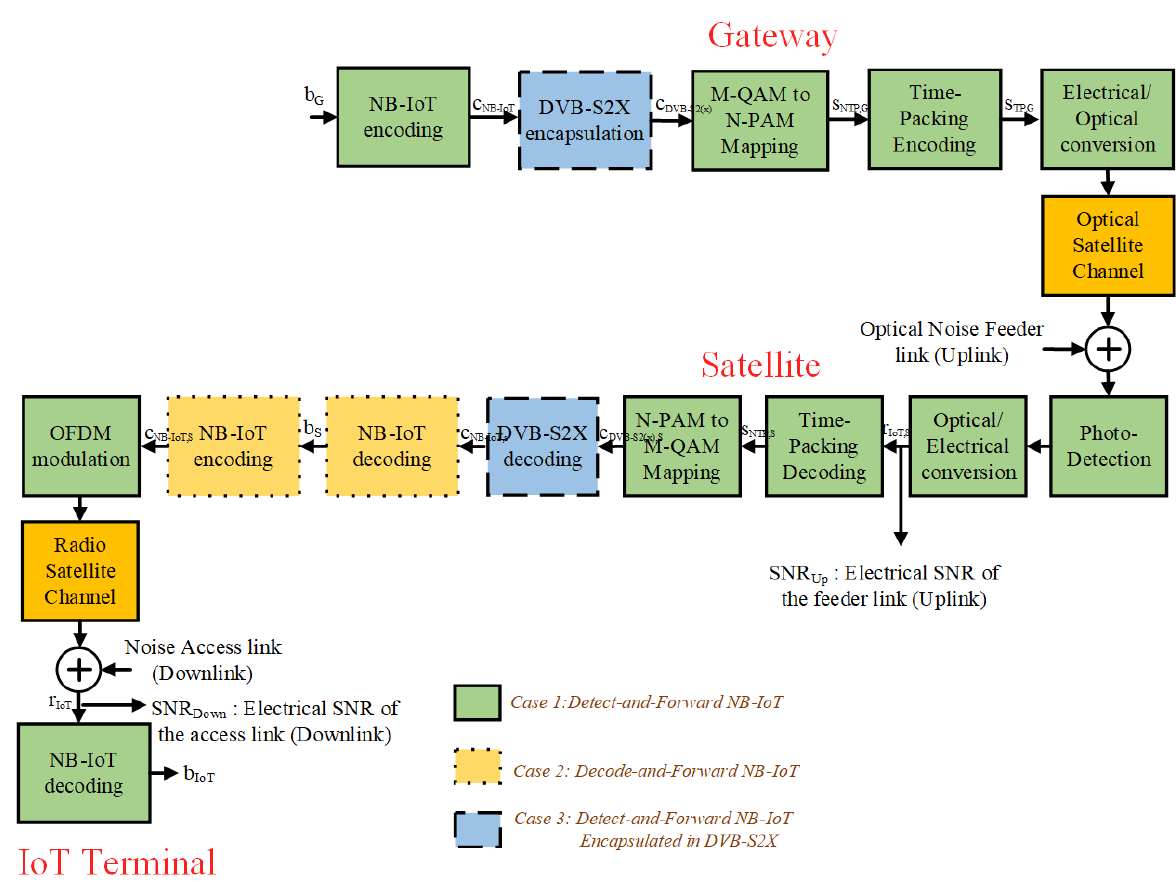
Figure 3. Block diagram of the GEO satellite forward link for the three relaying configurations under analysis: (1) Detect- and-Forward with NB-IoT (green blocks with solid edges); (2) Decode-and-Forward with NB-IoT (orange blocks with dotted edges); and (3) Detect-and Forward with NB-IoT/DVB-S2(X) (blue blocks with dashed